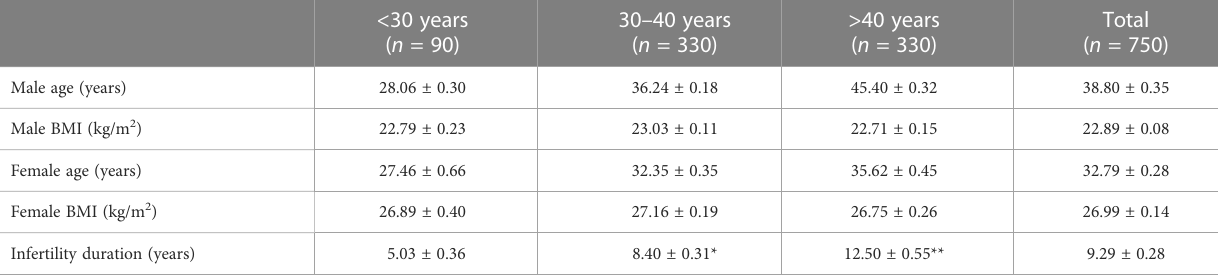
TABLE 1 Demographic characteristics of couples included in the study.